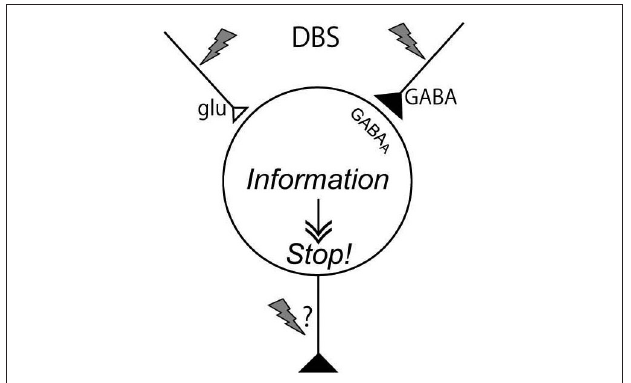
FIGURE 5 | Mechanism underling effectiveness of deep brain stimulation (DBS) . DBS activates axon terminals in the stimulated nucleus and induces release of large amount of neurotransmitters, such as GABA and glutamate, and dissociates inputs and outputs in the stimulated nucleus, resulting in disruption of abnormal information flow through the cortico-basal ganglia